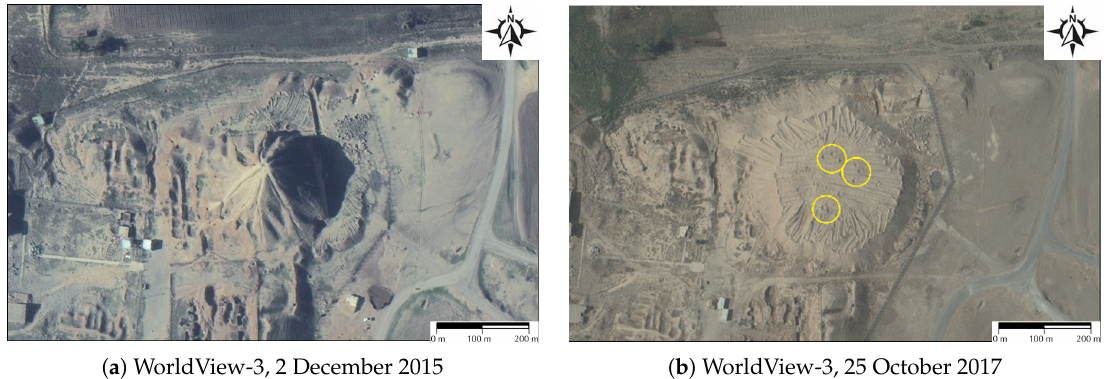
Figure 8. Earth movement damage type. The Ziggurat of Nimrud was bulldozed to the ground. The marks of the bulldoze are clearly visible in the image, as well as posterior looting in the form of small excavations (highlighted in yellow) c (cid:13) DigitalGlobe.